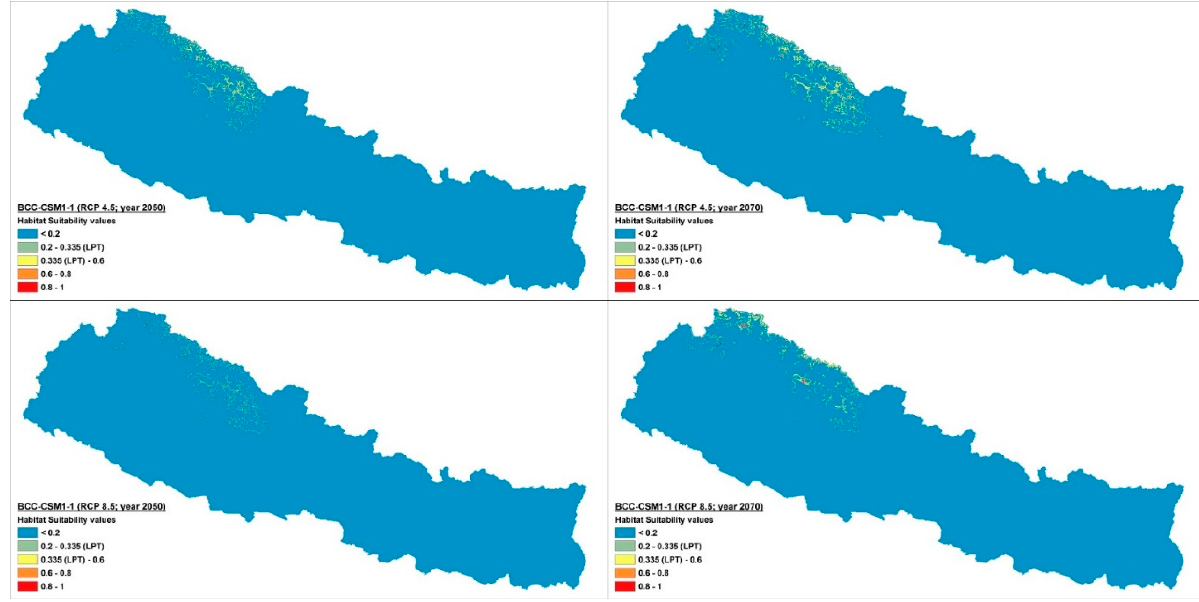
Figure 3. Climate change scenario under BCC-CSM1 model, RCP 4.5 and 8.5 at 2050 and 2070.